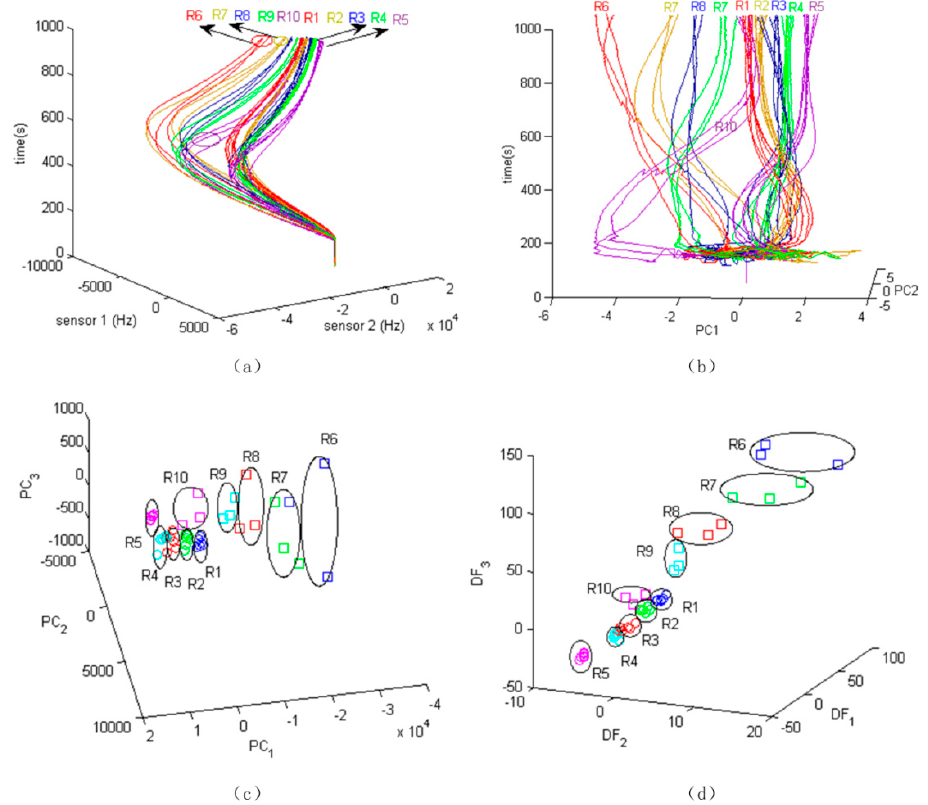
Figure 4. ( a ) Time development trajectories based on Sensor 1 (PE) and Sensor 2 (PSB) data; ( b ) Time development trajectories based on PC1 and PC2 scores; ( c ) three-dimensional (3D) scatter plot of Principal components; and, ( d ) discriminate functions of the pheromone blend data points at t = 650 s after injection.